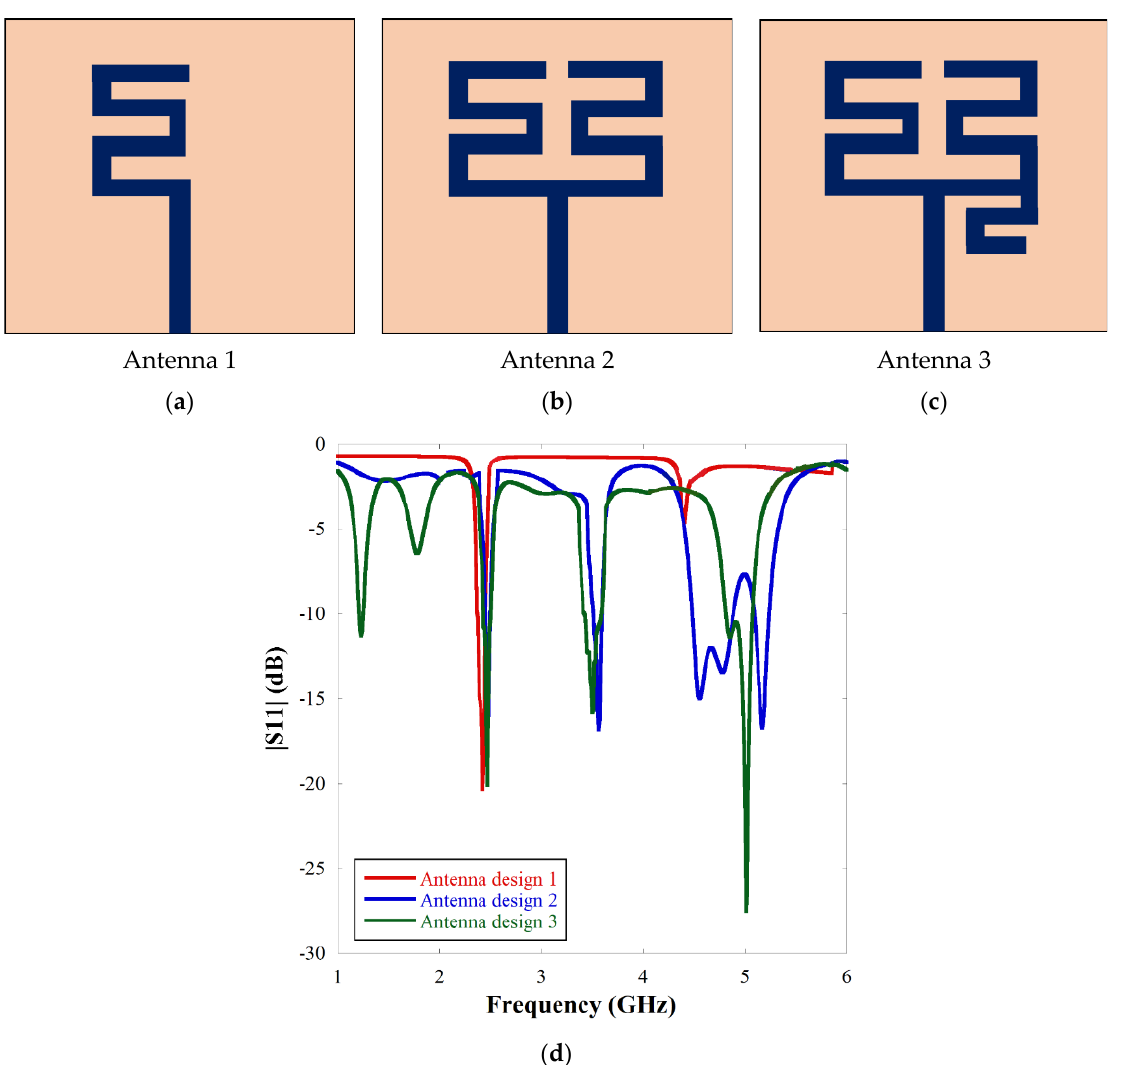
Figure 1. The evolution of meander-line antenna: ( a ) first step, ( b ) second step, ( c ) third step of antenna design and ( d ) |S11| characteristics according to the design evolution.